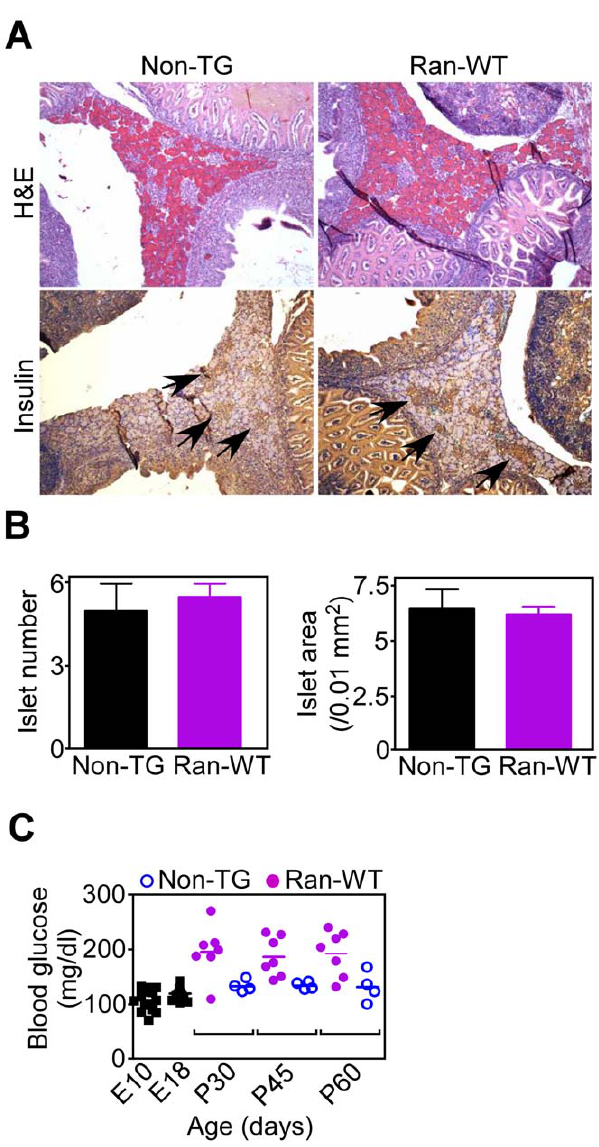
Figure 5. Postnatal defect in islet development in Ran transgenic mice. A , E18 non-TG or Ran-WT embryos were analyzed by H&E or immunohistochemical staining with an antibody to insulin. Arrows , insulin-stained islets. B , Islet number ( left ), or islet surface area ( right ), was quantified in E18 non-TG or Ran-WT transgenic embryos by morphometry of insulin-stained sections. The differences among groups are not statistically significant. C , Littermates of Ran-WT diabetic mice crossed with normal mice were analyzed for changes in blood glucose levels at the indicated time intervals. E, embryonic; P, postnatal. Glucose levels in PCR-confirmed non-TG ( open circles ) or Ran-WT transgenic ( closed circles ) mice are shown. Each point corresponds to an individual mouse. Glucose concentrations (mg/dl) in each group (number of mice in parentheses), and statistical analyses versus E18 values are as follows: E10 (n=15), 108.7 6 4.93; E18 (n=15), 120.7 6 2.7; P30 Ran-WT (n=7), 196.3 6 17.8, p , 0.0001; P30 non-TG (n=4), 134 6 5.4; P45 Ran-WT (n=7), 187.1 6 13.5, p , 0.0001; P45 non-TG